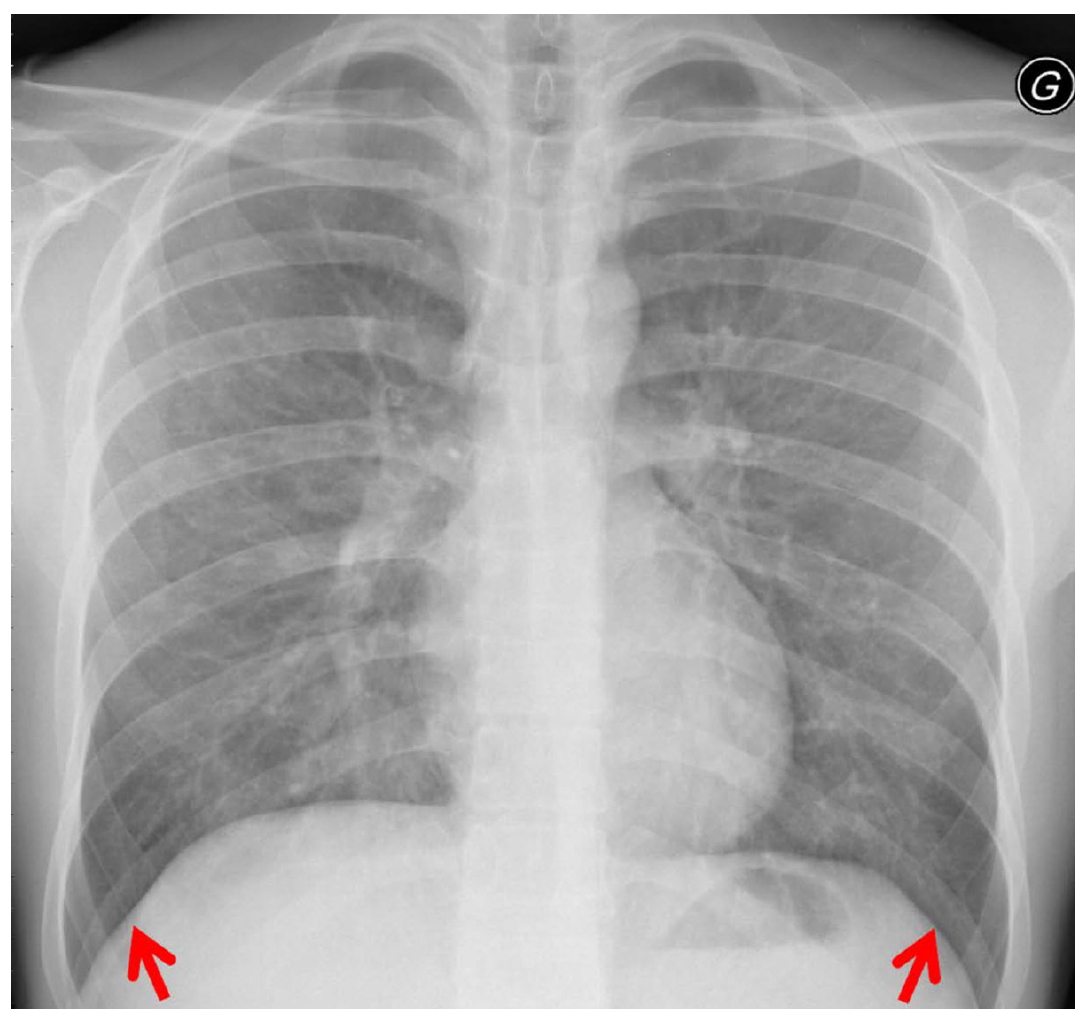
Figure 5: Faint homogeneous central ground glass opacity with sparing of the caudal lungs/sinus phrenicocostalis (arrows) in a renal trans- plant